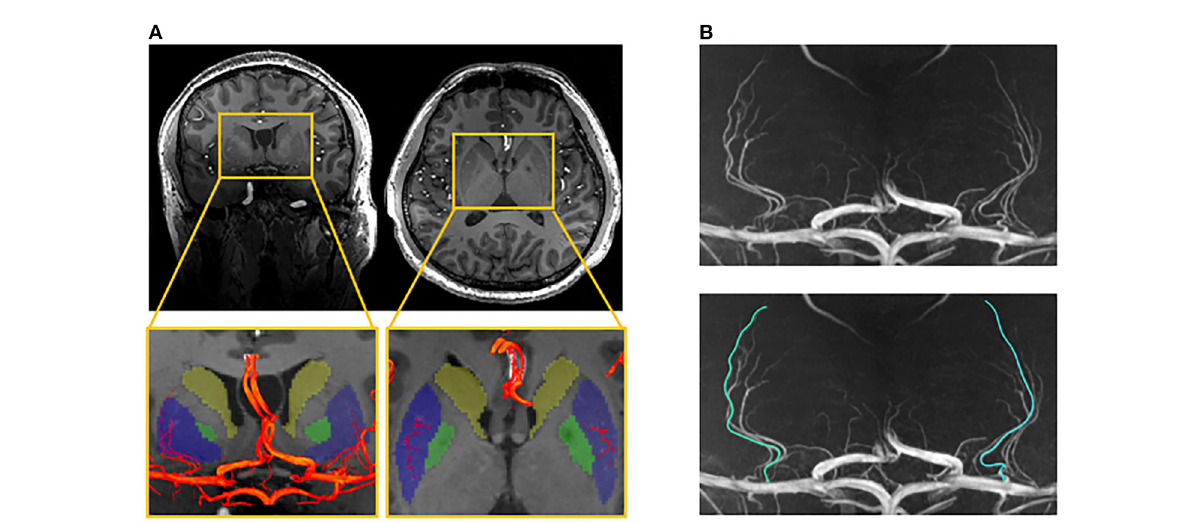
FIGURE1 Illustration of the measurements of lenticulostriate arteries (LSAs). (A) The LSAs (red) and their supplying territories (basal ganglia), overlaying on the structural image (blue: putamen; green: globus pallidum; yellow: caudate); (B) The coronal maximal intensity projection of TOF-MRA, on which the curved length of LSA was